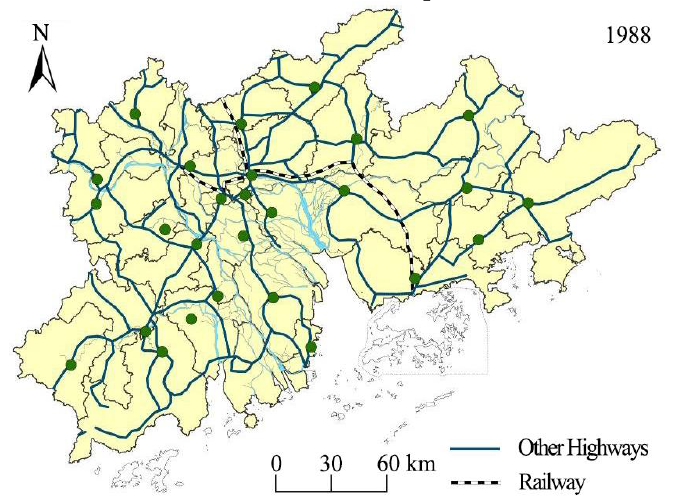
Figure 2a: The evolution of land-based transport network in the PRD,